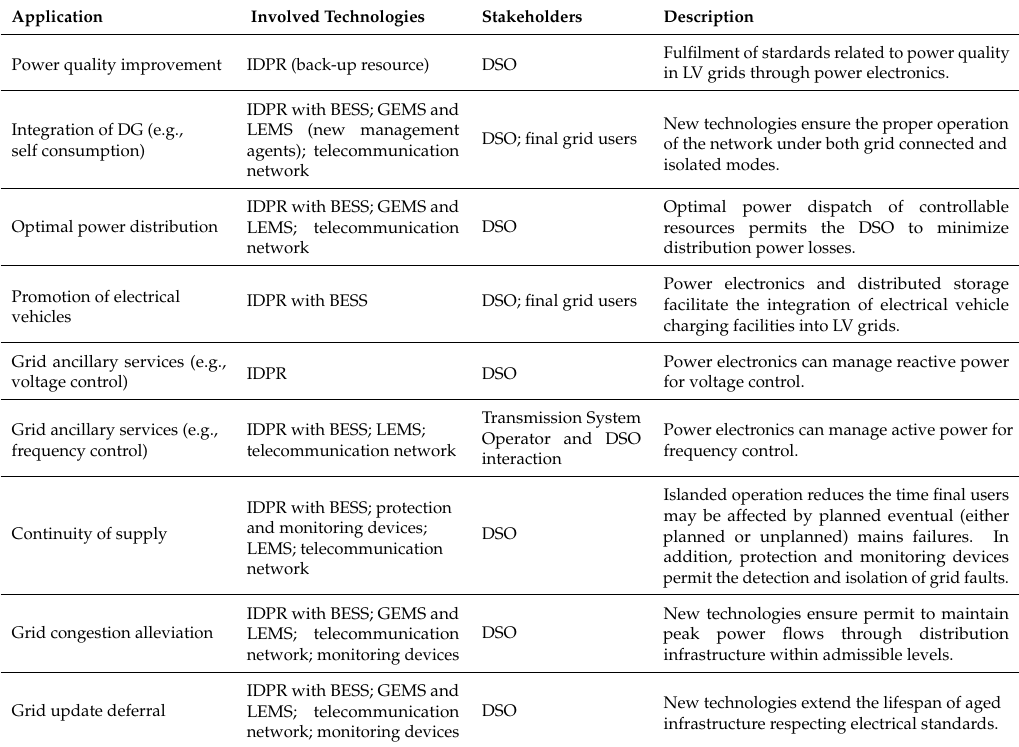
Table 2. Applications of the new technologies evolving the distribution grid